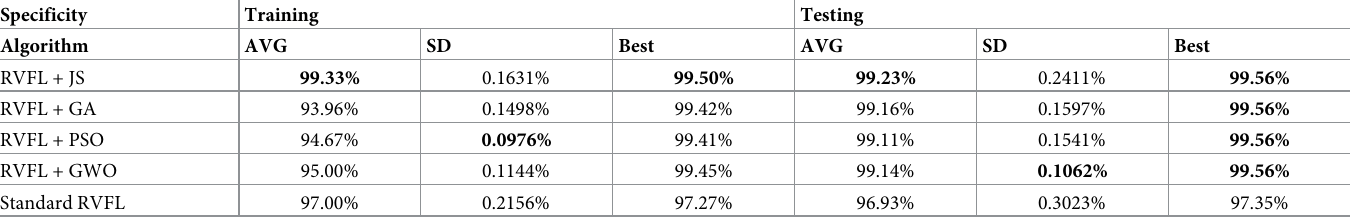
Table 9. Measurement specificity of RVFL+ JS against other metaheuristic